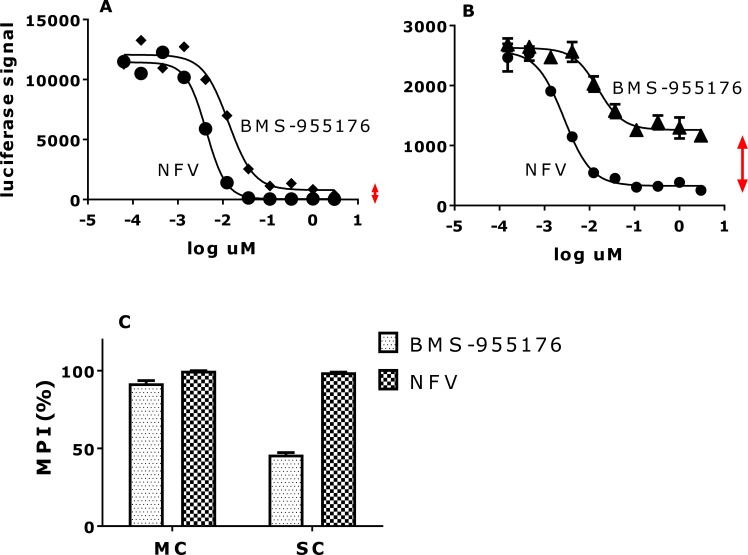
Comparison of antiviral inhibition profiles of the ΔV370 virus by BMS-955176 in MC and SC assays.Dose-response curves for BMS-955176 (diamonds) and NFV control (circles) in the A) MC and B) SC assay toward the NLRepRlucP373ΔV370 virus; vertical double-headed arrows highlight differences in residual signal (100-MPI) between the two compounds in the two antiviral formats, C) comparison of MPI data for A and B. Data shown an average of 3 experiments.